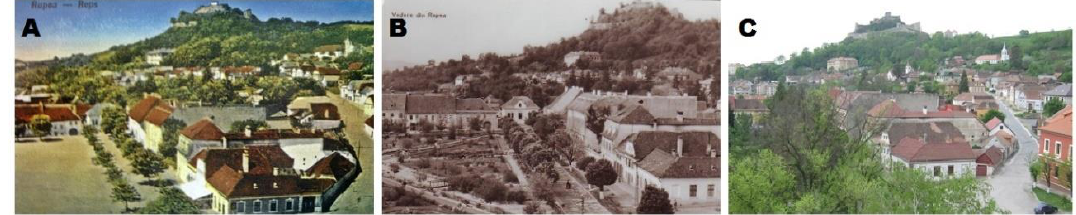
Figure 7: Functional reconversion of the central square in Rupea town, A – postcard from 1930, B – postcard from 1969, C – photograph taken in